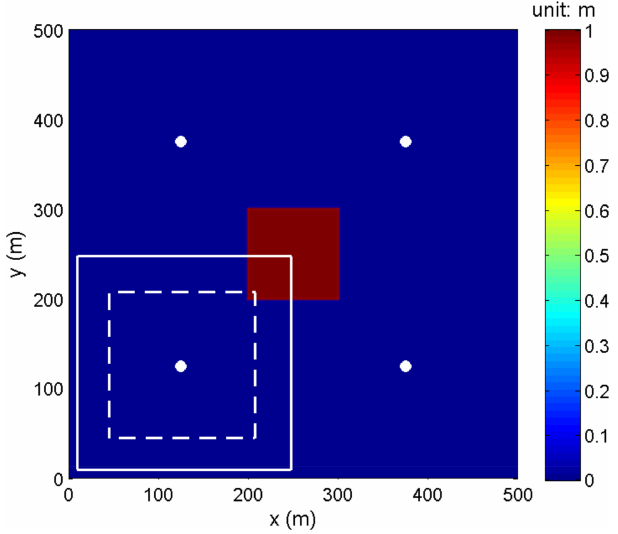
Figure 5. Wave generation from an initial 1m elevation still-water hump. The parent grid, Grid 1, covers the entire domain, and solid and dashed lines mark the boundaries of Grid 2 and Grid 3, respec- tively. Bullets mark locations of numerical wave gauges for com- paring free-surface